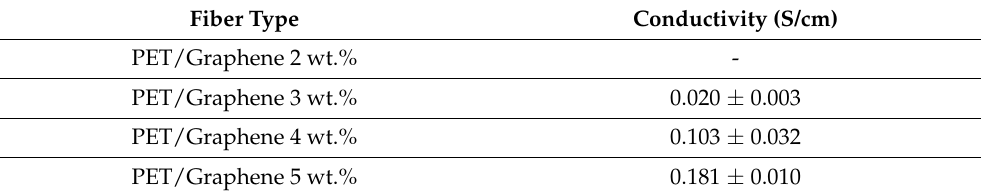
Table 2. Conductivity values for fibers containing different graphene loadings.